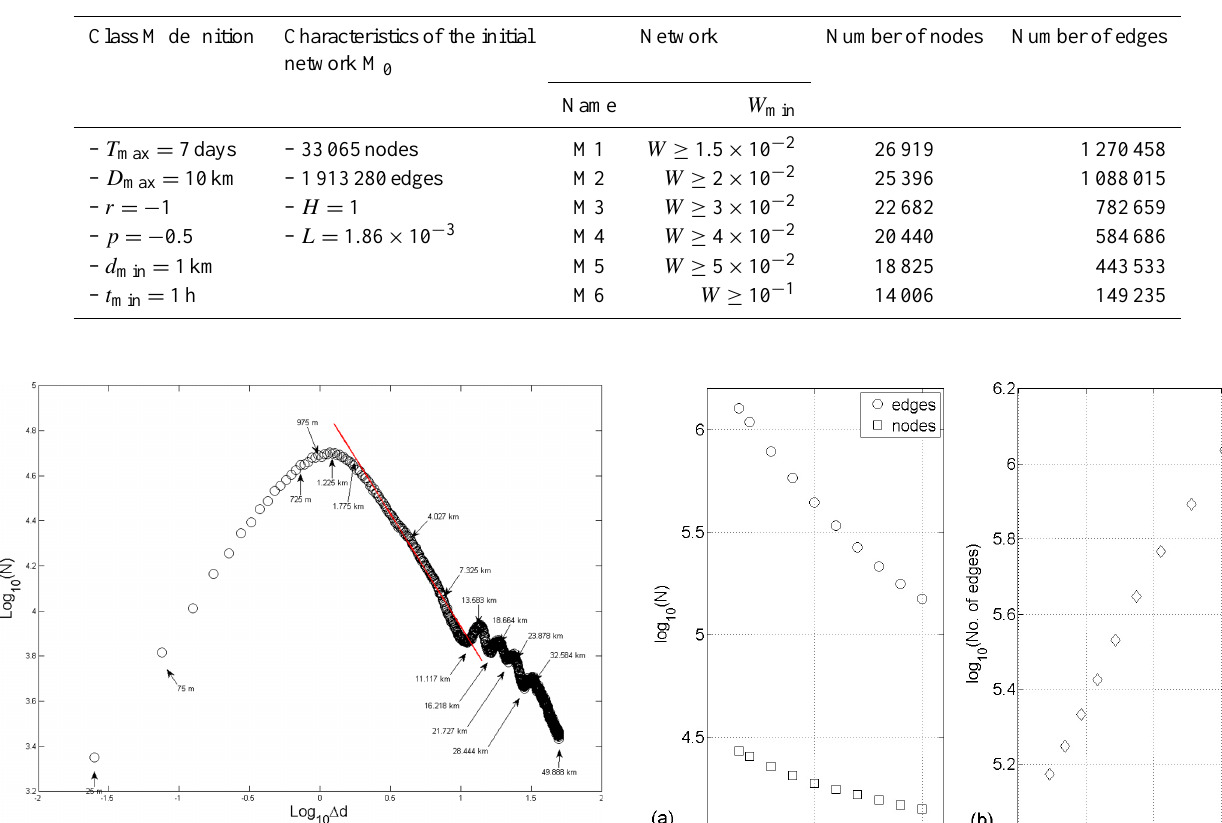
Table 3. Class M networks. M 0 is the initial network that was generated using the parameter values shown in the first column. See Table 1 for the meaning of T max , D max , r , p , d min , t min , H , and L .